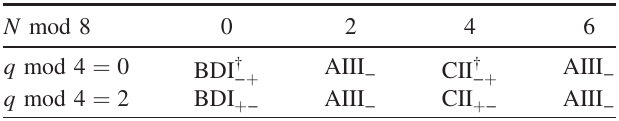
TABLE VI. Symmetry classes realized in the chiral two-matrix model H with Hermitian SYK blocks H , H 0 .